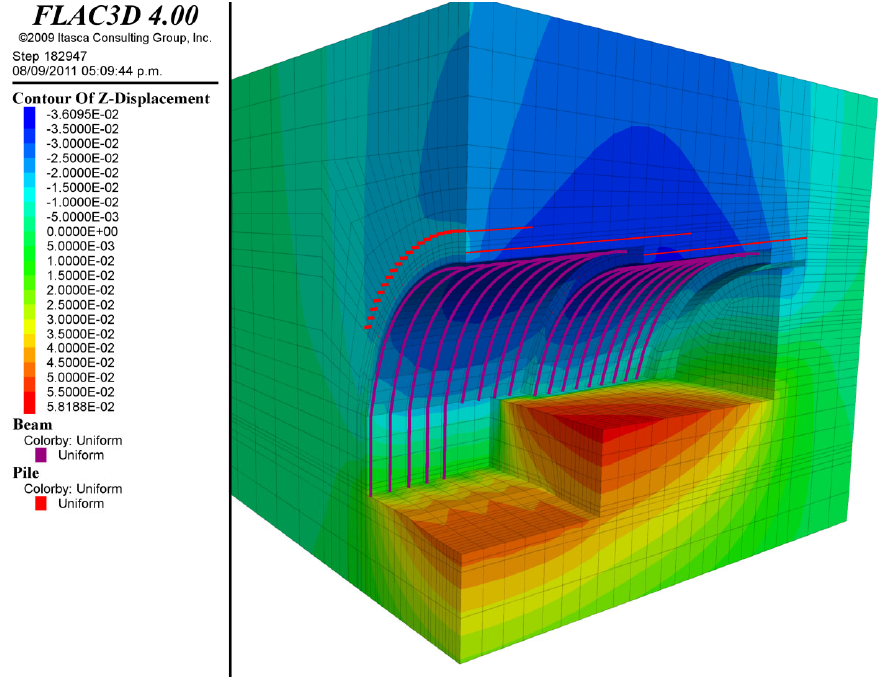
Figure 10. Vertical displacements (Uz in meters) in an intermediate stage of the excavation. Minimum parameters [12].